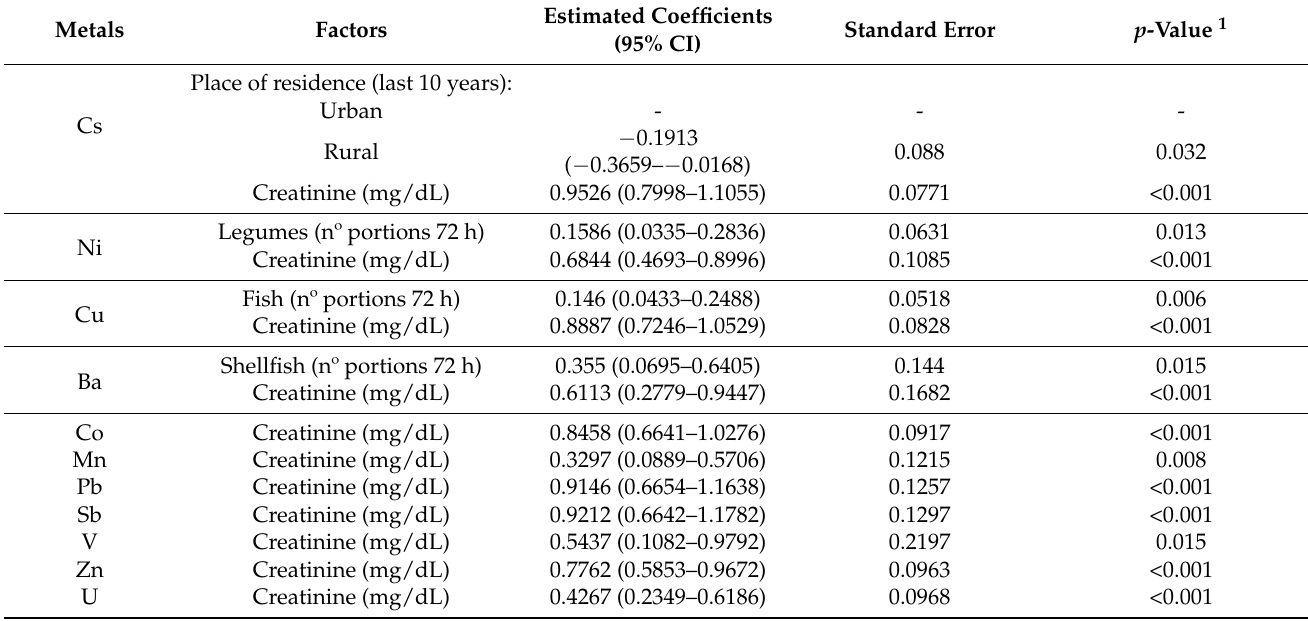
Table 3. Results of the multiple linear regression models for log (elements) concentrations in the urine of Spanish